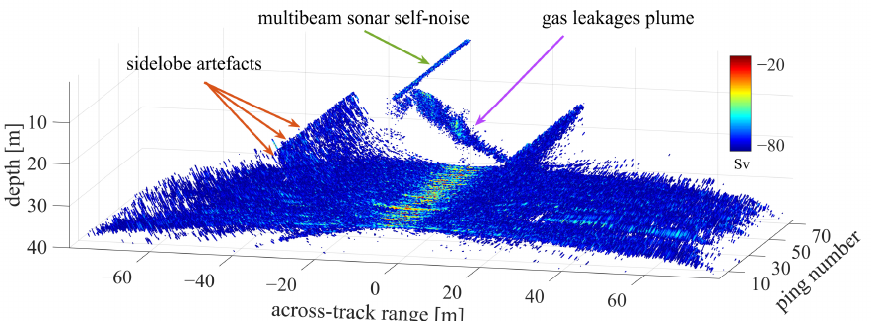
Figure 11. The three-dimensional (3D) point cloud data extracted from 120 consecutive water column images. A 3D gas leakage plume can be observed in this image, and it is tilted due to the horizontal current. The sidelobe artifacts and unfiltered noise also exist in the 3D space, and they appear as strong 3D structures that interfere with the 3D structure of a gas leakage plume. The presented intensities denote relative intensities.